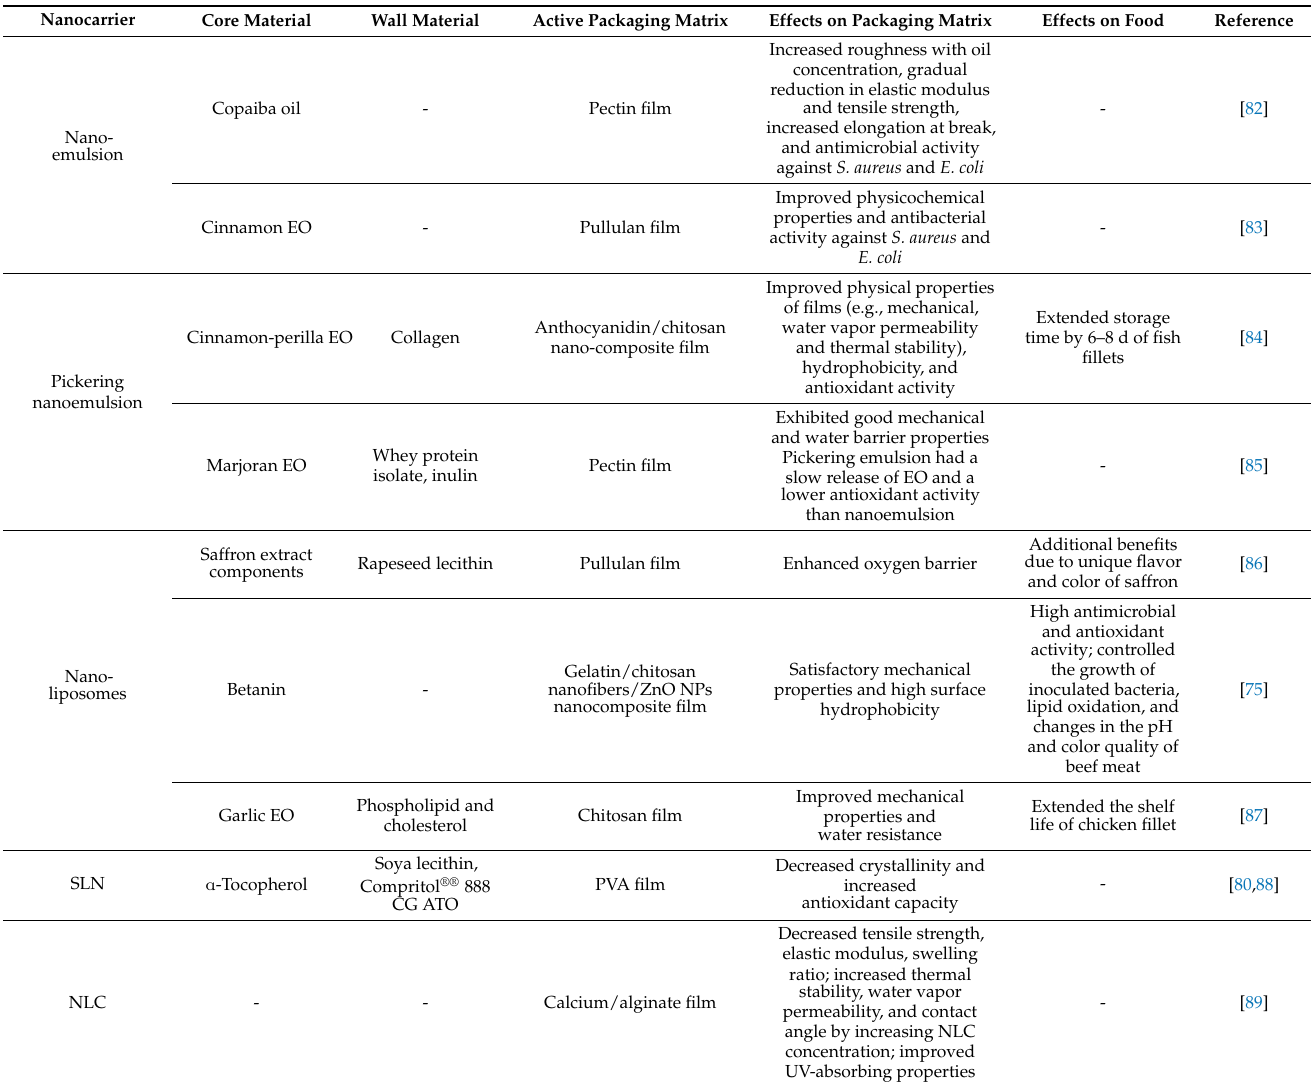
Table 2. Recent examples of improved active packaging by lipid-based nanocarriers